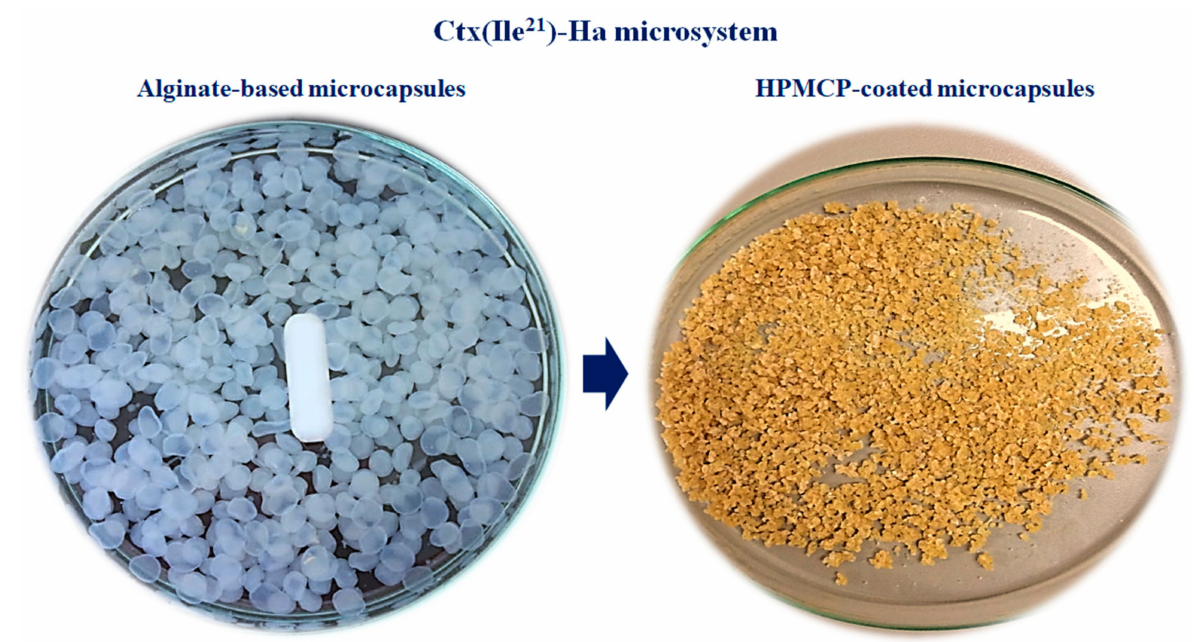
Figure 2. Microcapsules obtained after ionic gelation and fluidized